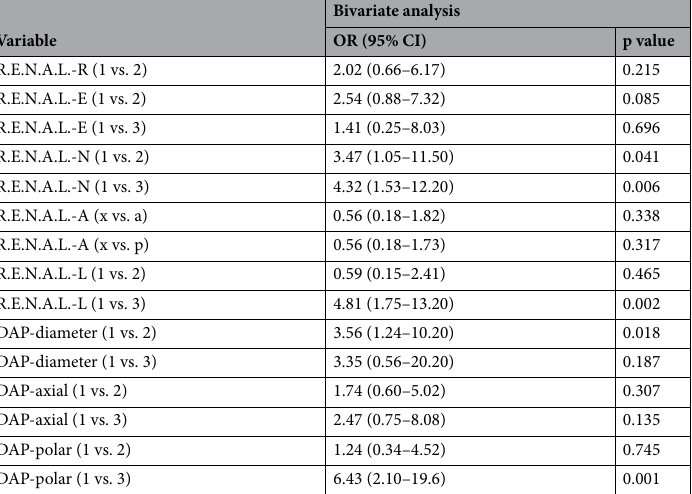
Table 3. Bivariate analysis of each factor of nephrometry scores for predicting postoperative eGFR decrease. R.E.N.A.L. Radius, exophytic/endophytic, nearness to collecting system or sinus, anterior/posterior, and location relative to polar lines; DAP Diameter-Axial-Polar; OR Odds ratio; CI confidence interval. R denotes the maximal diameter of the tumor, with 1 point for a tumor size ≤ 4 cm and 2 points for a tumor size 4–7 cm. E represents the exophytic or endophytic properties of the tumor, with 1 point for ≥ 50% exophytic, 2 points for < 50% exophytic, and 3 points for entirely endophytic. N denotes the nearness of the tumor to the collecting system, with 1 point for ≥ 7 mm, 2 points for 4–7 mm, and 3 points for ≤ 4 mm. A represents whether the tumor is located anterior (a) or posterior (p) to the kidney midline plane. When the tumor grows from the renal poles or arises from the kidney so that a meaningful anterior or posterior designation is not possible, (x) is assigned. L denotes the location relative to the polar lines, with 1 point indicating that the lesion is above the upper or below the lower polar line, 2 points indicating that the lesion crosses the polar line, and 3 points indicating that > 50% of the mass is across the polar line, the tumor crosses the axial renal midline, or the mass is entirely between the polar lines. Diameter represents the maximal diameter of the tumor, with 1 point for a tumor size < 2.4 cm, 2 points for ≥ 2.4–4 cm, and 3 points for > 4 cm. Axial denotes the axial distance from the center point to the closest tumor edge, with 1 point for > 1.5 cm, 2 points for ≤ 1.5 cm, and 3 points for the tumor touching or overlapping the center point. Polar represents the polar distance from the middle plane to the closest tumor edge, with 1 point for > 2 cm, 2 points for ≤ 2 cm, and 3 points for the tumor crossing the axial renal midline.